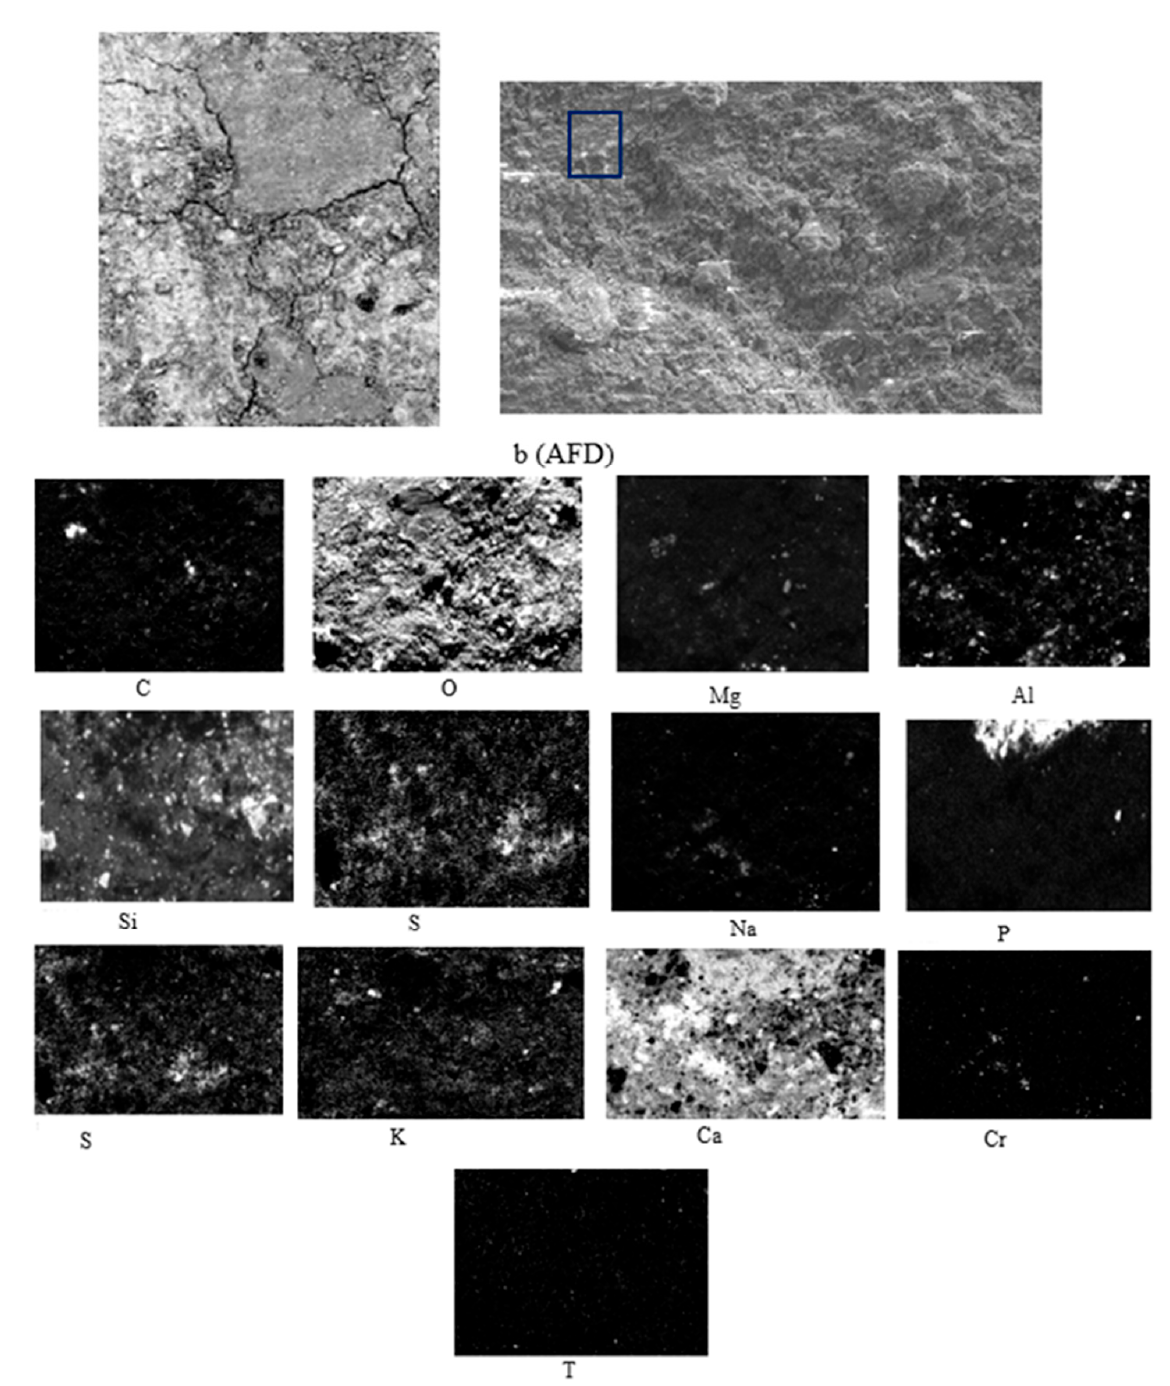
Figure 9. SEM-BSE of AFD and EDS map of element distribution in TRAD mortar sample. (b) Sampling. The SEM results of ferritic material are shown in Figure